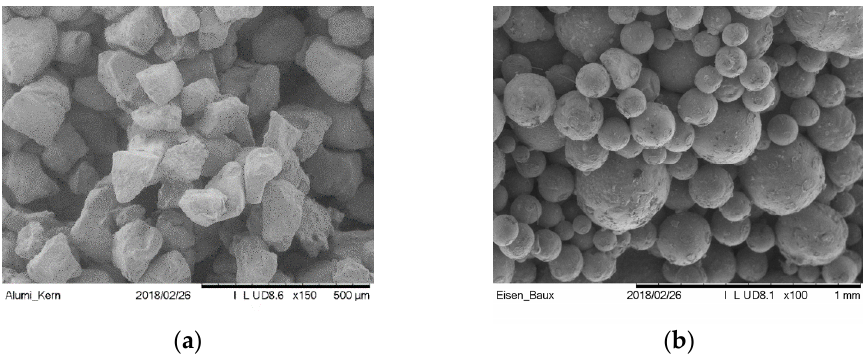
Figure 6. SEM-Micrographs of different qualities of sand suitable for the Binder Jetting of tools: ( a ) Silica Sand type GS14 RP by Strobel Quarzsand GmbH Freihung, Germany, and ( b ) Bauxitsand by Hüttenes Albertus GmbH Düsseldorf, Germany.